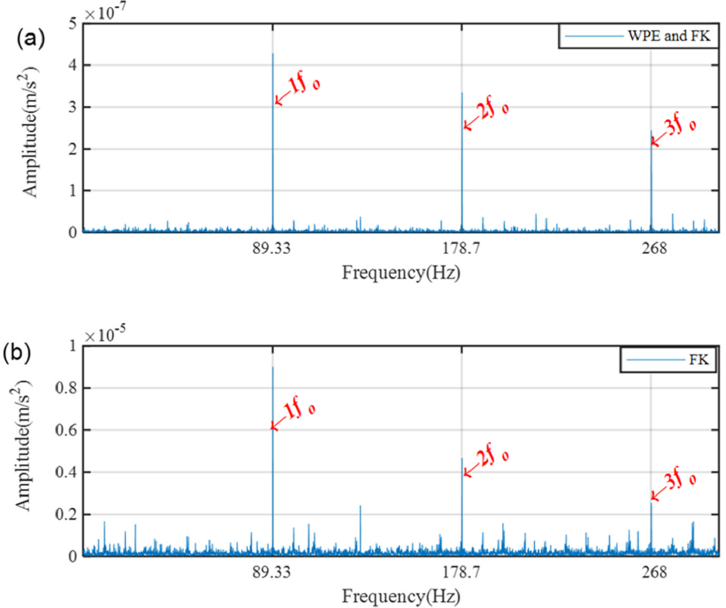
Figure 12. The results of the motor bearing outer race fault vibration signal: ( a ) the proposed method; ( b ) individual FK method.